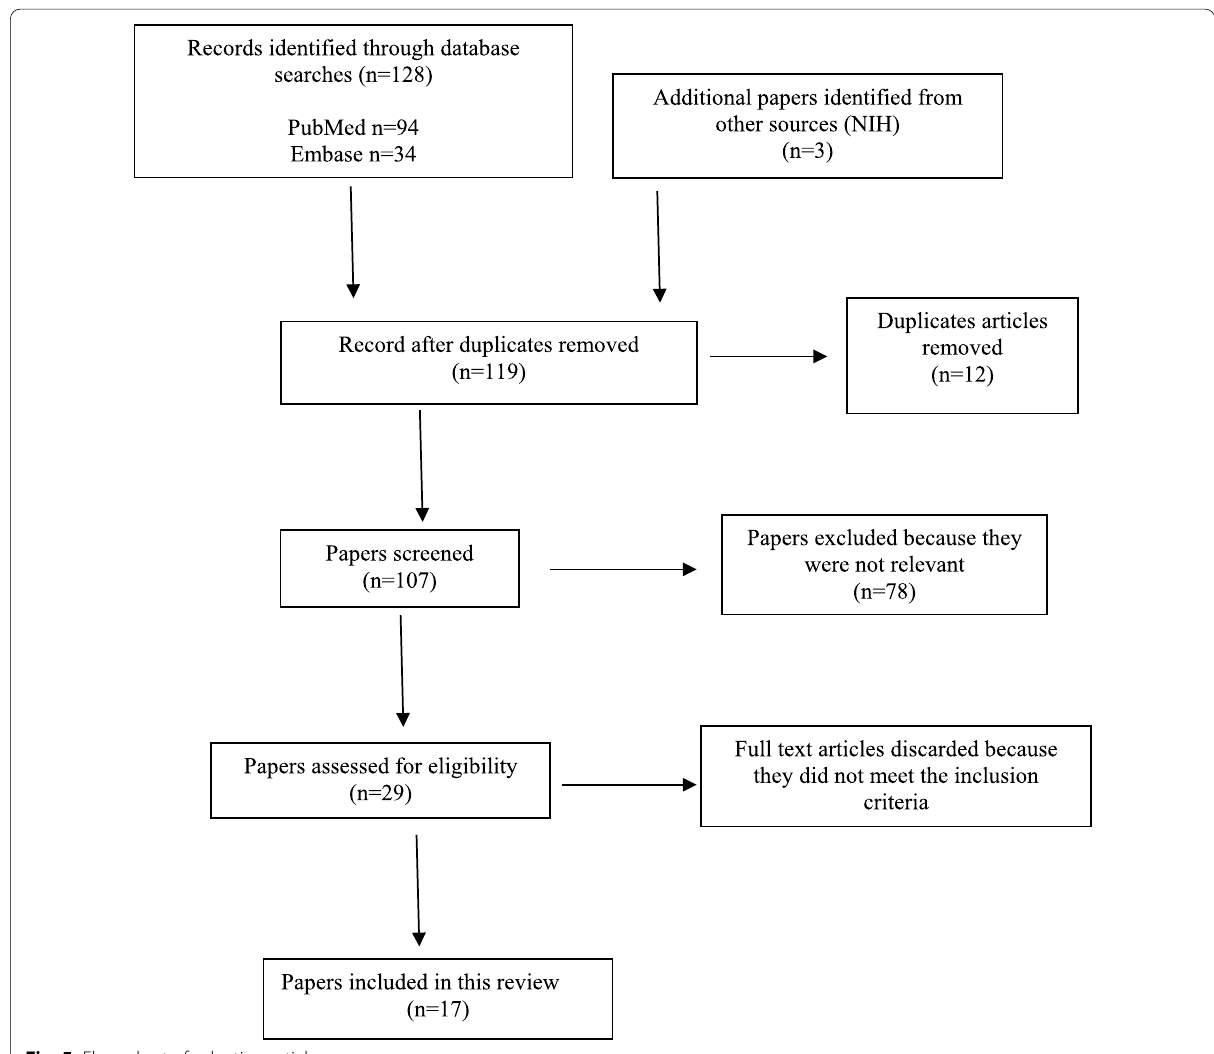
Fig. 5 Flow‑chart of selection